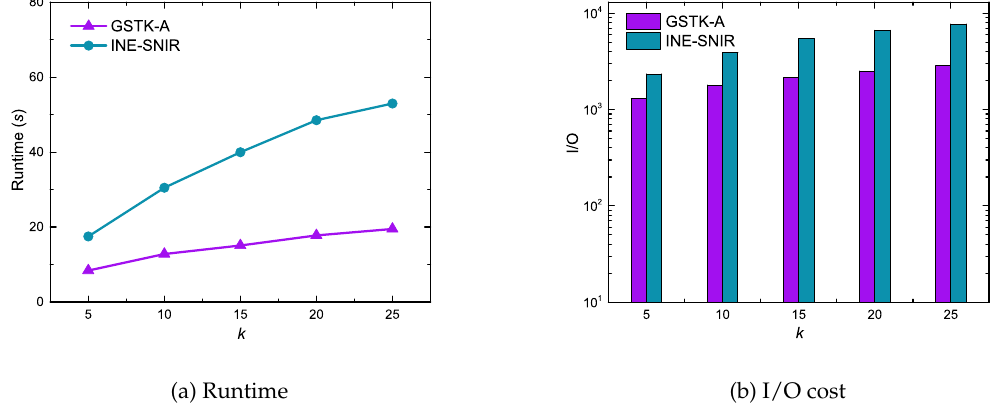
Figure 7. Effect of k on runtime and I/O cost.